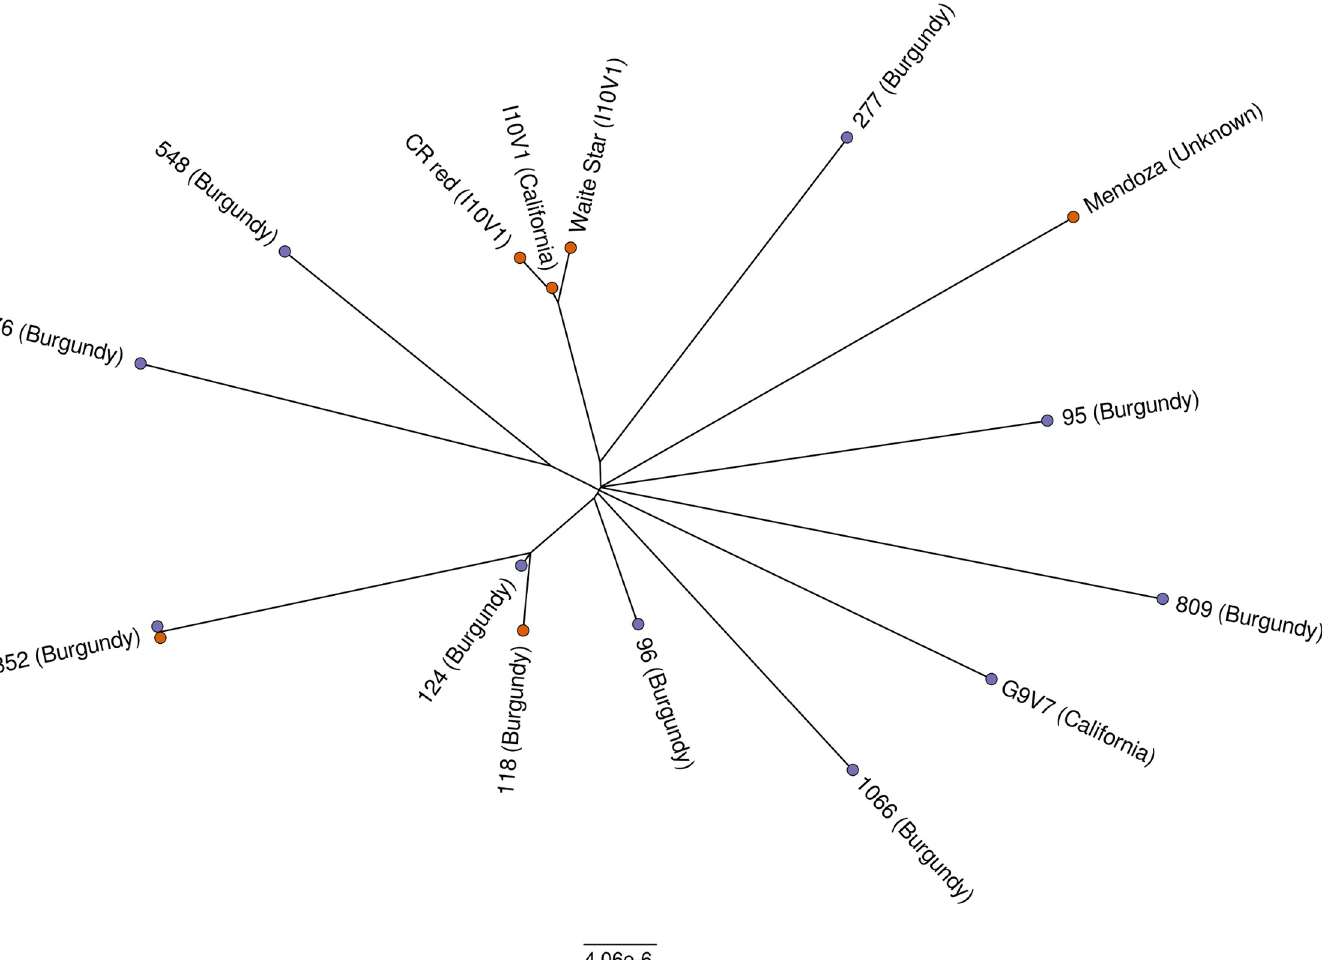
Fig 4. Genetic diversity in Chardonnay clones. An unrooted tree of Chardonnay clones based upon bi-allelic SNPs. Sequencing batches are designated by coloured terminal nodes (orange, sequencing batch #1; purple, sequencing batch #2).